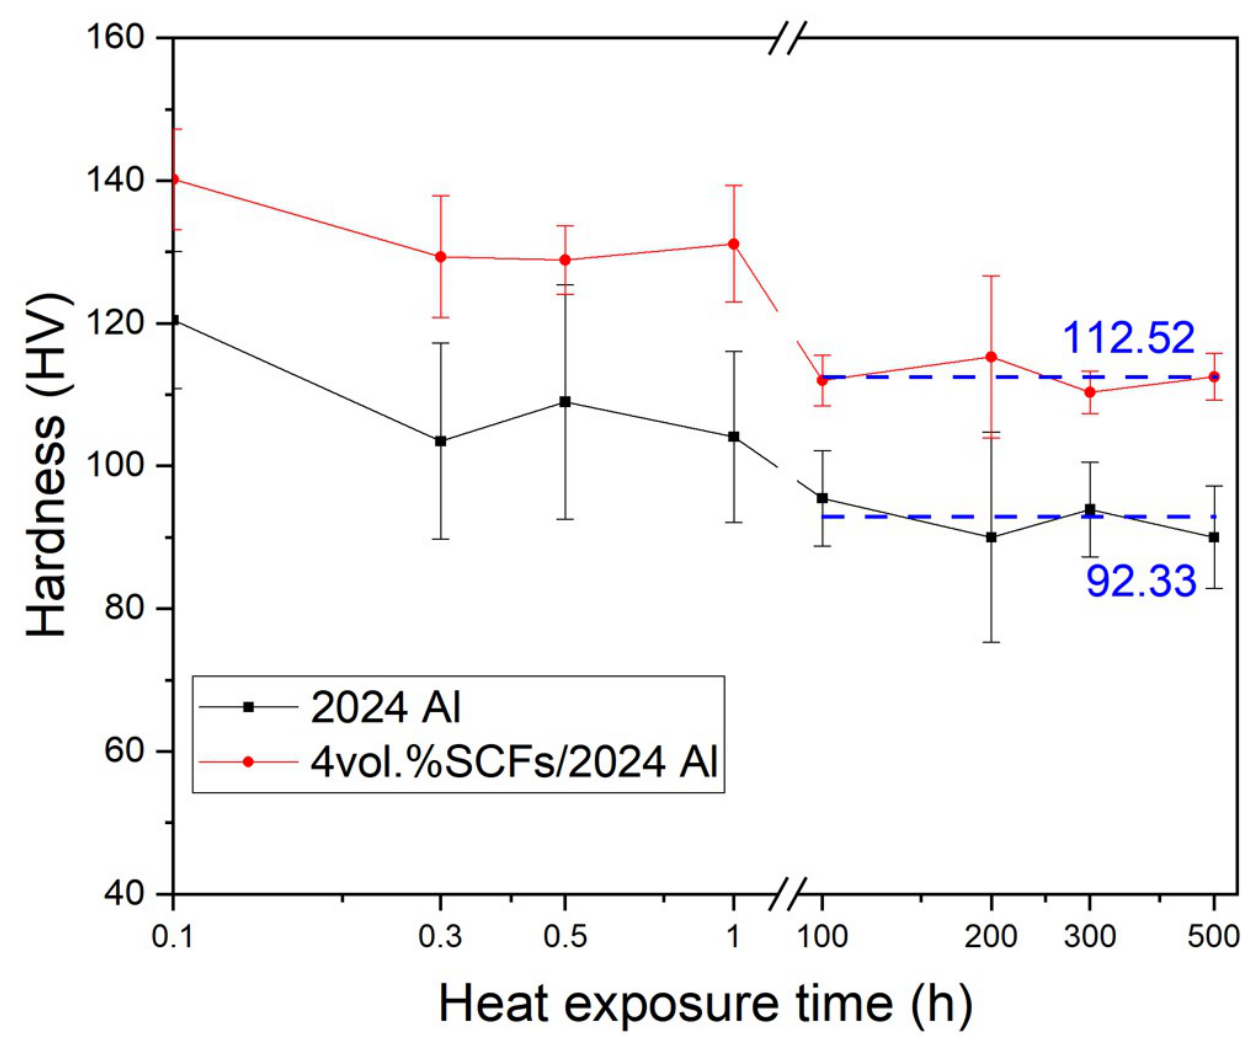
Figure 6. Hardness of 2024 Al and SCFs/2024 Al with the change of thermal exposure time. (Samples without thermal exposure are defined as 0.1 h).